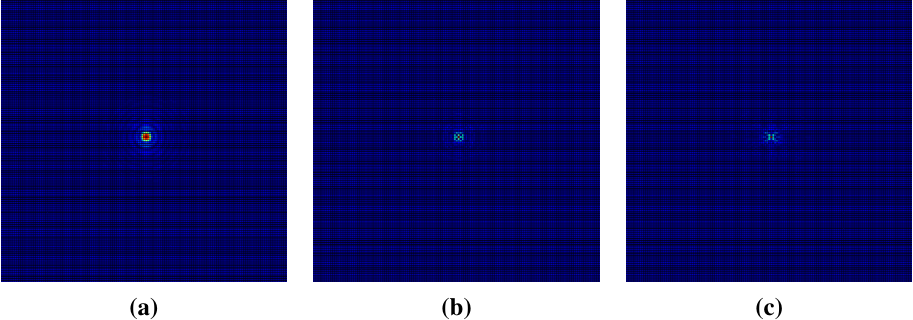
Figure 13. Fourier spectrums of ( a ) subR1, ( b ) subR2 and ( c ) subR3.